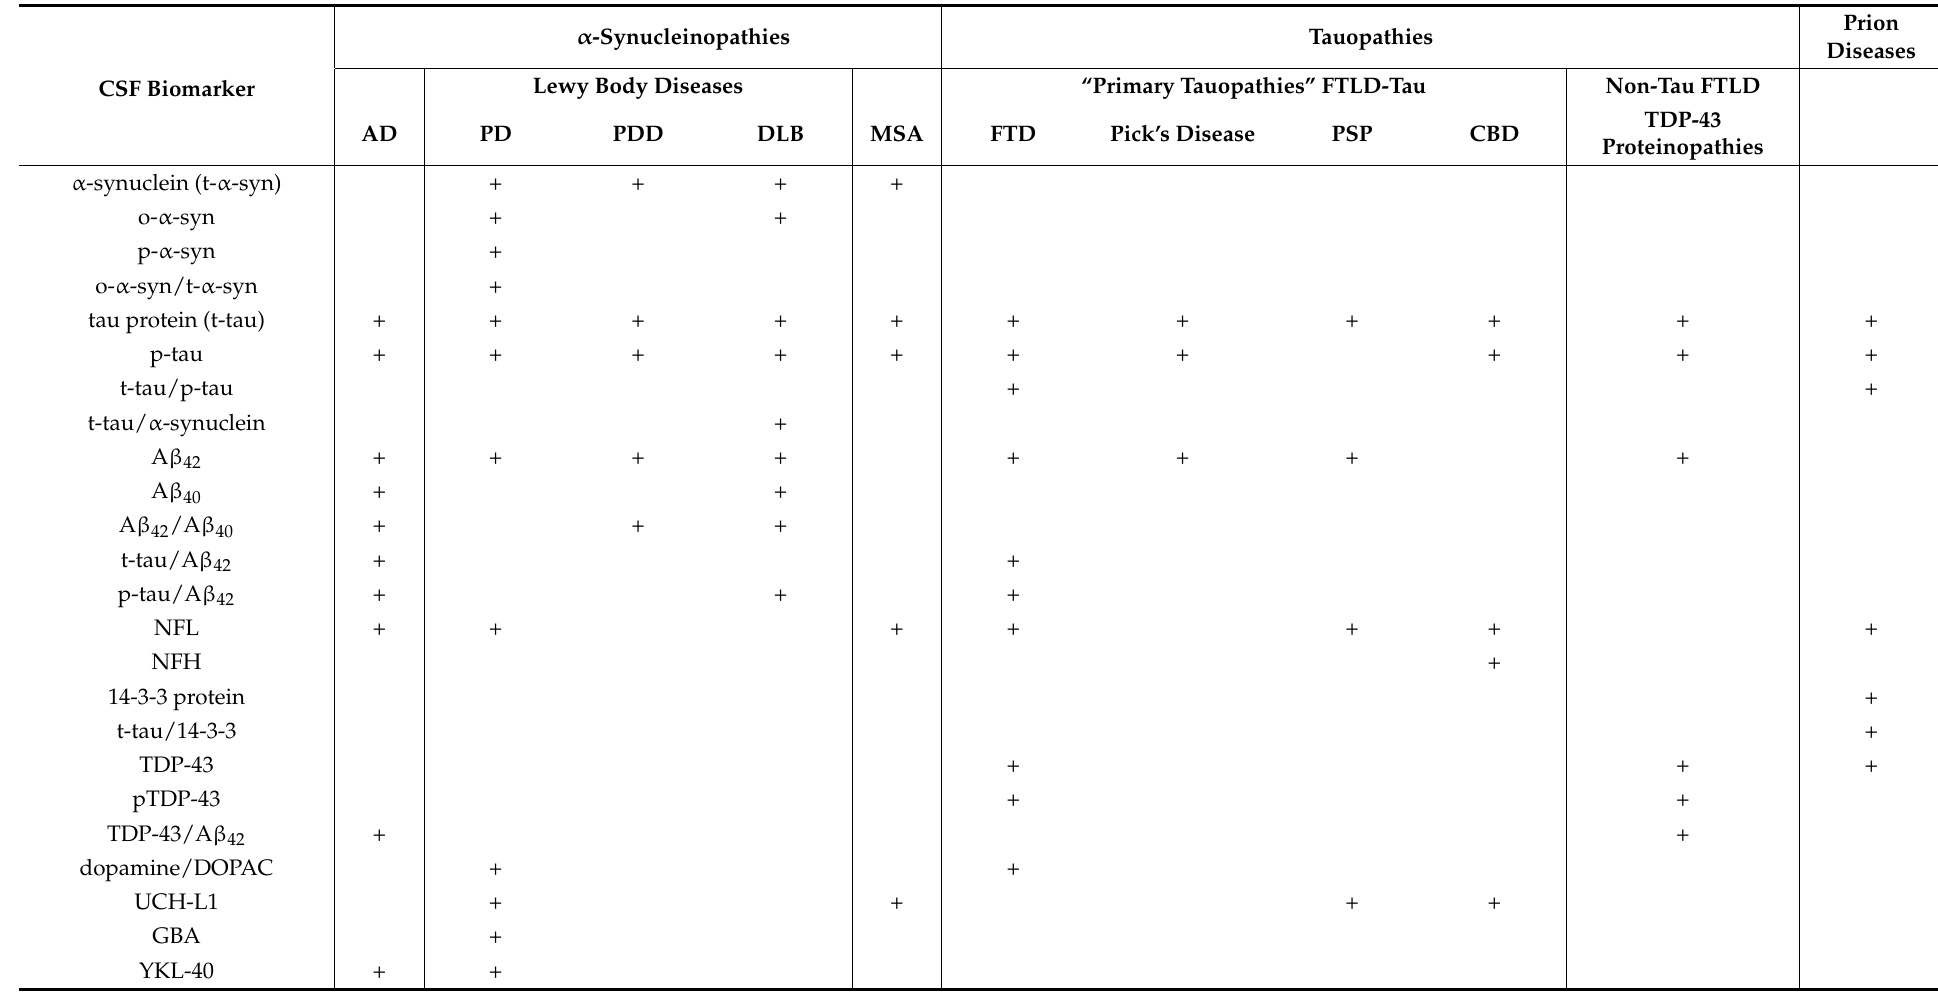
Table 1. CSF biomarkers for individual groups of neurodegenerative diseases.